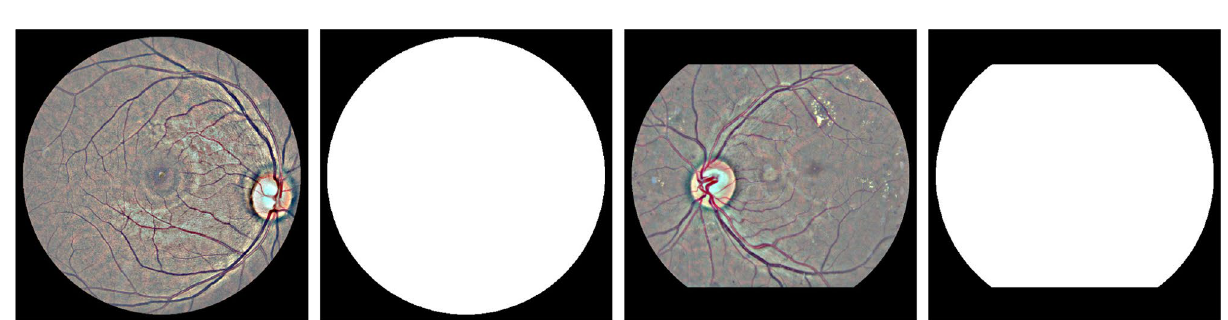
Figure 2. Samples of pre-processed retinal images (left) along with their corresponding binary retina masks